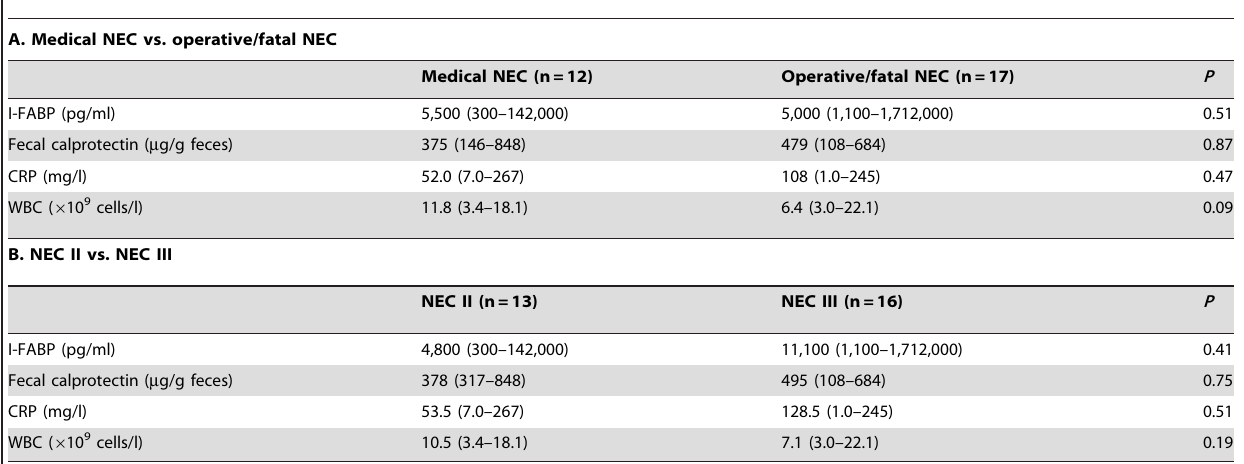
Table 3. Values of IFABP, calprotectin, CRP and WBC at